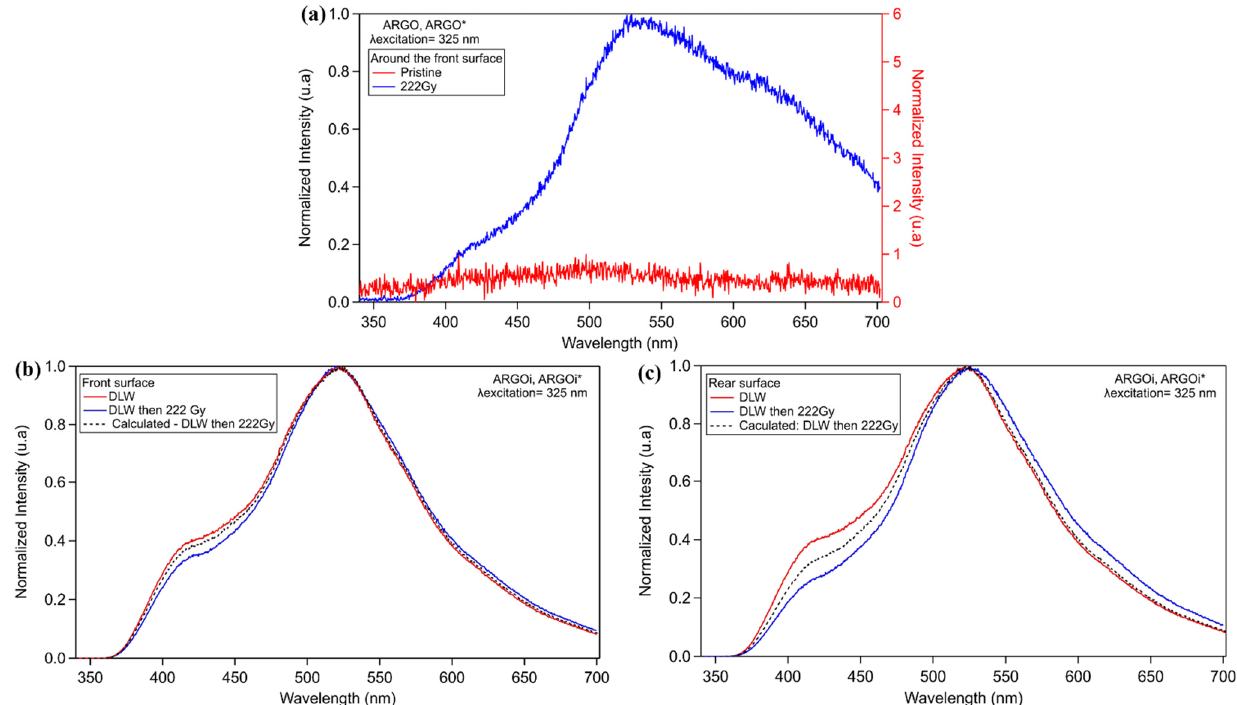
Figure 8. Normalized RPL spectra excited at 325 nm: ( a ) for the ARGO (pristine—right axis) and ARGO* (X-ray irradiation at 222 Gy—left axis) glasses collected around 150 µm below the surface, ( b , c ) for the highest DLW irradiance structure for ARGOi and ARGOi* in the front- and the rear- inscribed surfaces, respectively.